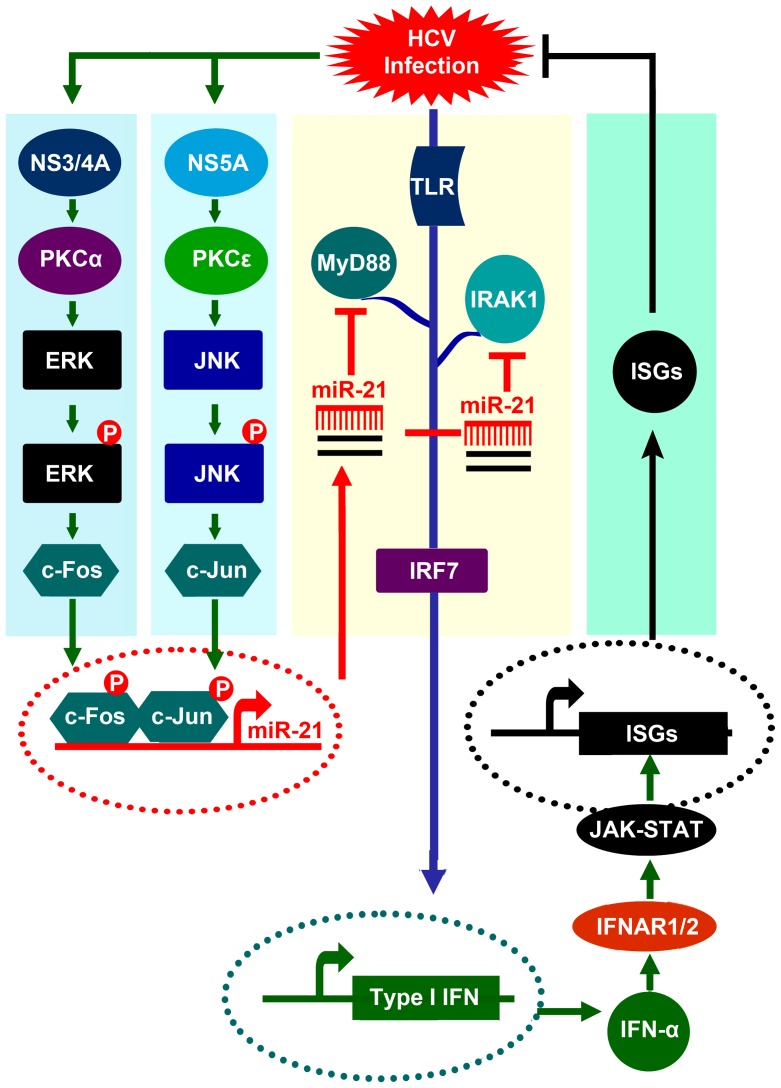
Proposed model for the activation of miR-21 expression upon HCV infection and the role of miR-21 in the regulation of the antiviral activity of type I IFN.During HCV infection, the virus is first recognized by TLRs and RIG-1, which in turn activates MyD88 and IRAK1 to initiate IFN-α synthesis, resulting in the activation of ISGs and the inhibition of HCV replication. In addition, miR-21 expression is activated during HCV infection through two signaling pathways: the PKCε/JNK/c-Jun pathway and the PKCα/ERK/c-Fos pathway. The HCV NS5A protein activates PKCε to enhance the expression of JNK and c-Jun, while the HCV NS3/4A complex stimulates PKCα to promote the production of ERK and c-Fos. The two subunits (c-Jun and c-Fos) of AP-1 join together to recognize the miR-21 promoter and activate the expression of miR-21, which represses the expression of MyD88 and IRAK1 via imperfect base pairing between miR-21 and the 3′UTR of MyD88 and IRAK1. The reduction in MyD88 and IRAK1 causes a reduction of type-I IFN production and ISG expression that might contribute to viral pathogenesis and virus propagation.